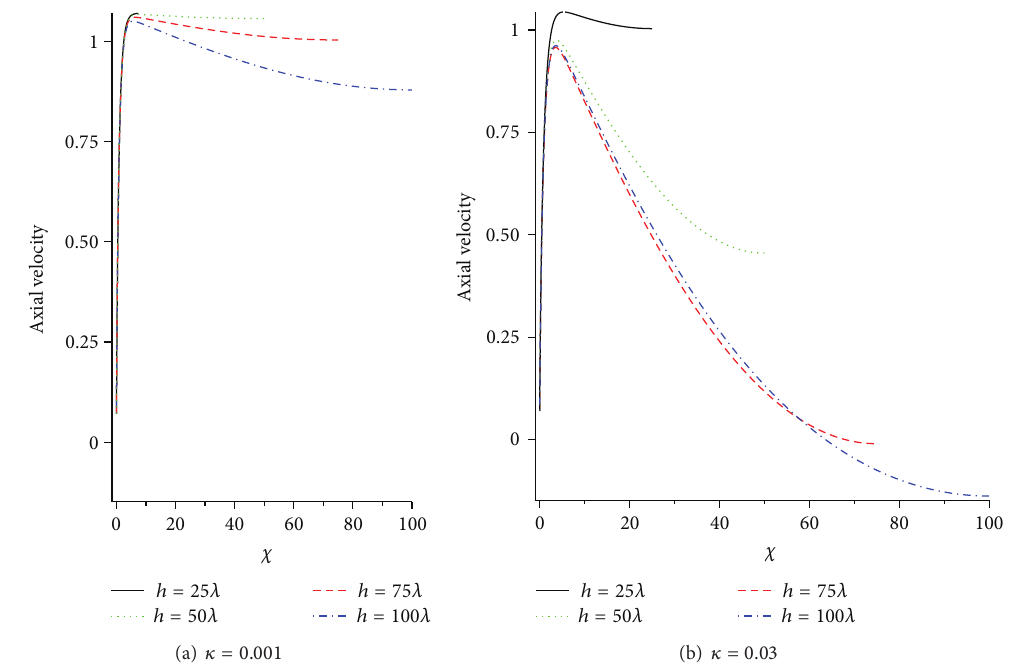
Figure 7: Effect of the channel half-height ℎ on the velocity profile obtained from the model with 𝜃 = 𝜋/2 , 𝛼 = 1 , and ℓ = 0.05 for two different 𝜅 values: (a) 𝜅 = 0.001 and (b) 𝜅 = 0.03